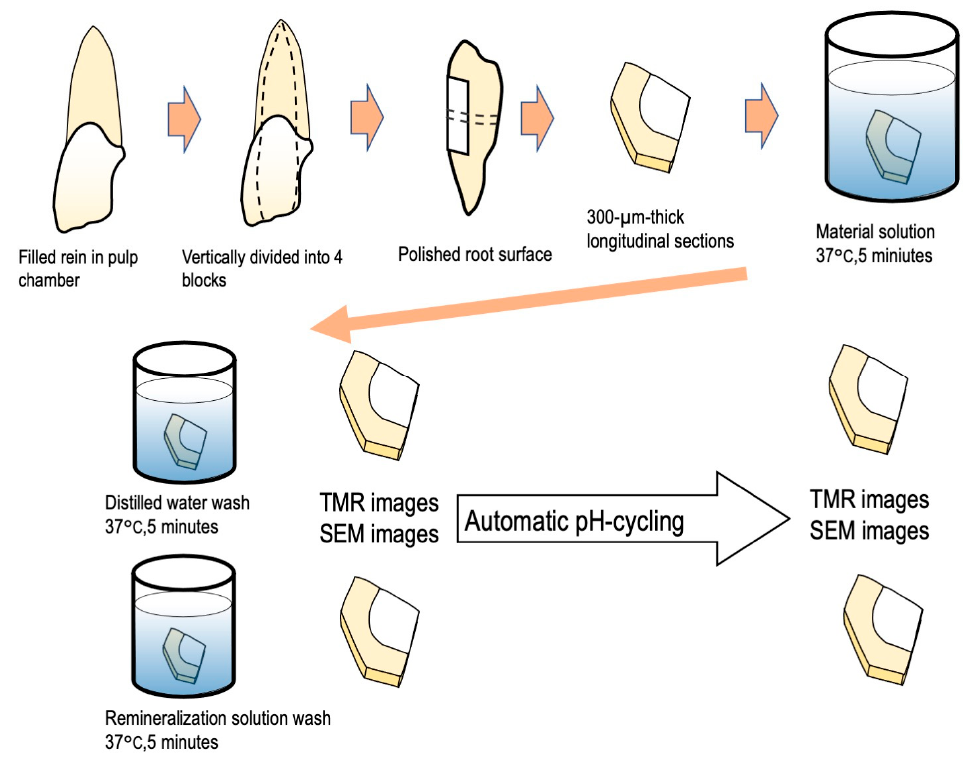
Figure 1. Experimental procedure for SEM and anti-demineralization analysis.